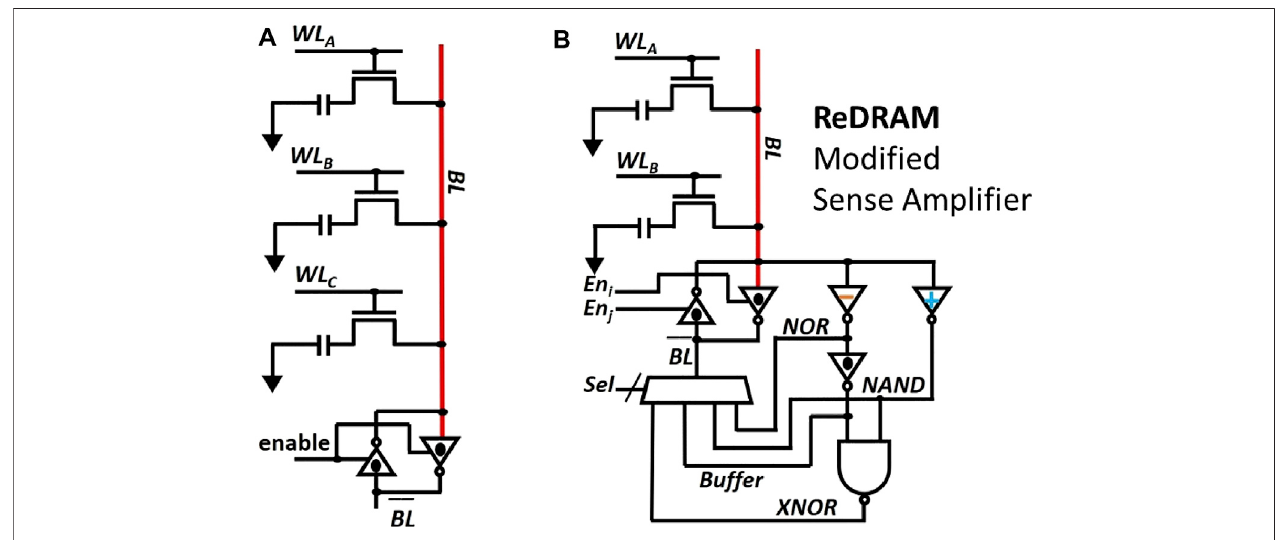
FIGURE 2 | Prior work (iPIM). Hardware architecture of (A) AMBIT (Seshadri et al., 2017) and (B) ReDRAM (Angizi and Fan, 2019b)